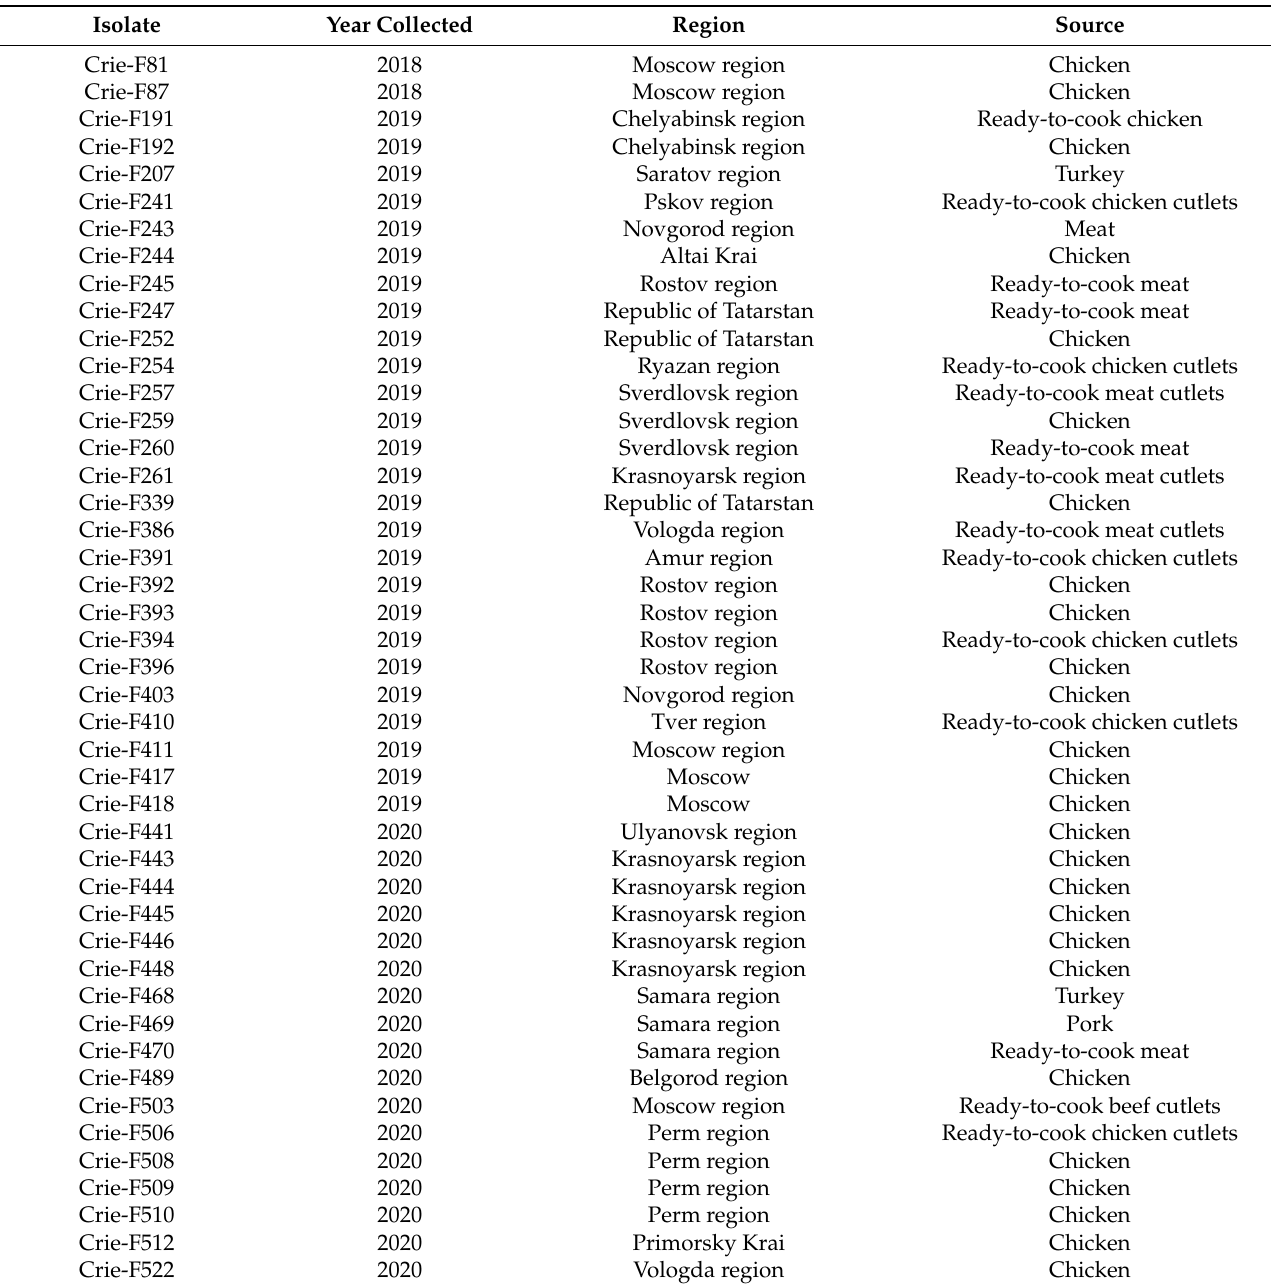
Table 1. The metadata for the foodborne S. Infantis isolates